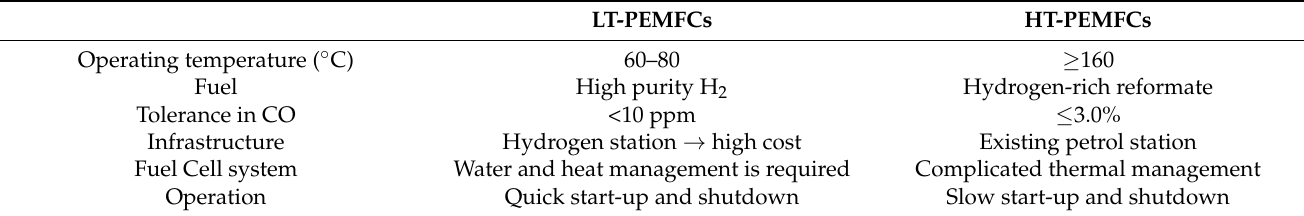
Table 5. Main characteristics of LT-PEMFCs and HT-PEMFCs. LT-PEMFCs